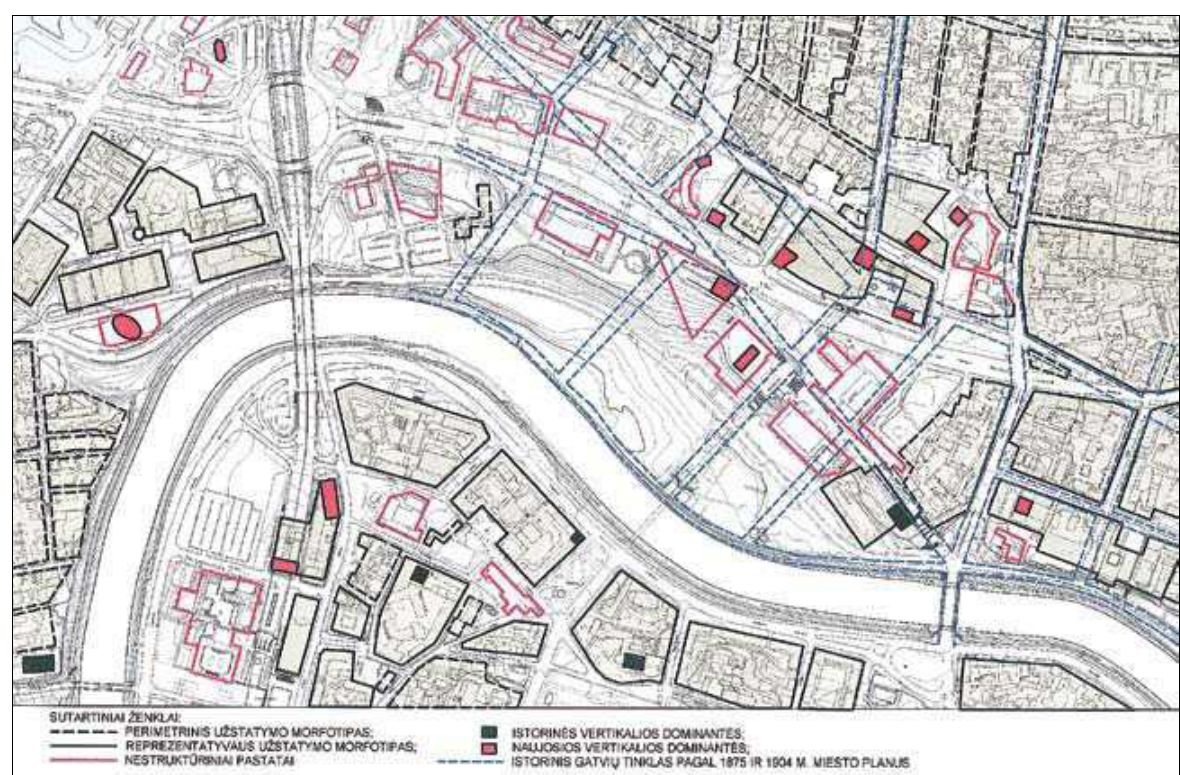
Fig. 1. existing built-up areas in 2009 with approximate street network in Vilnius city Plan of